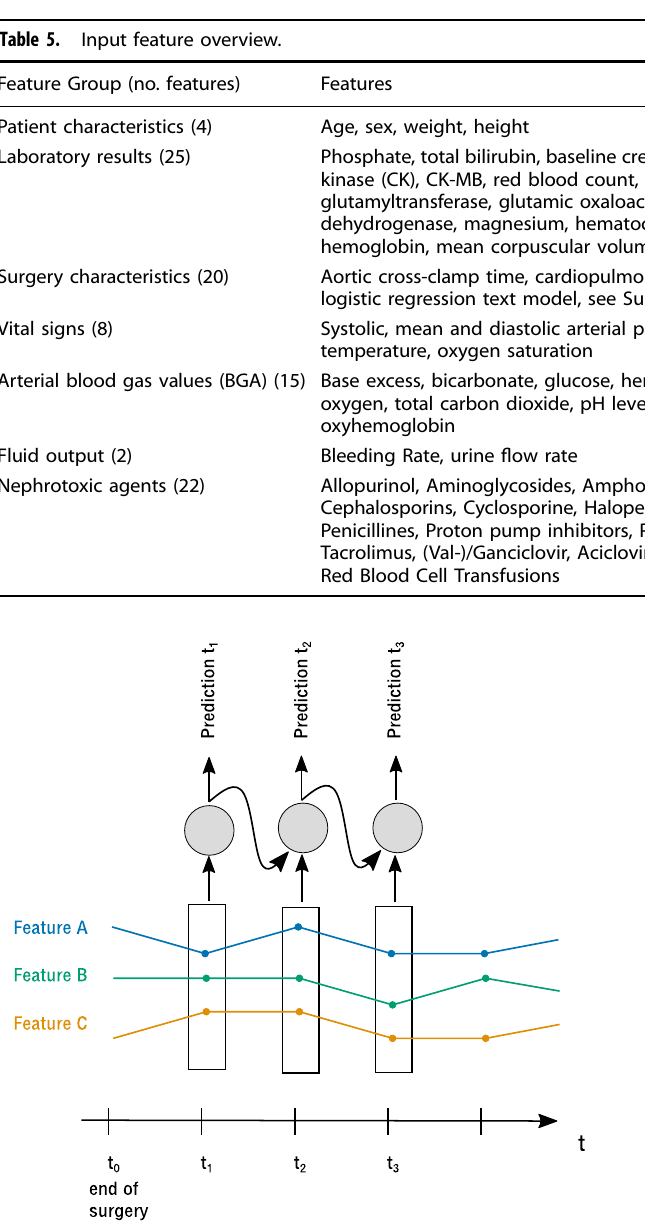
Fig. 5 Architecture of a recurrent neural network (RNN). At each time step, the model receives the current time slice data as input as well as the own output from the preceding time step. The features are captured in a truly sequential